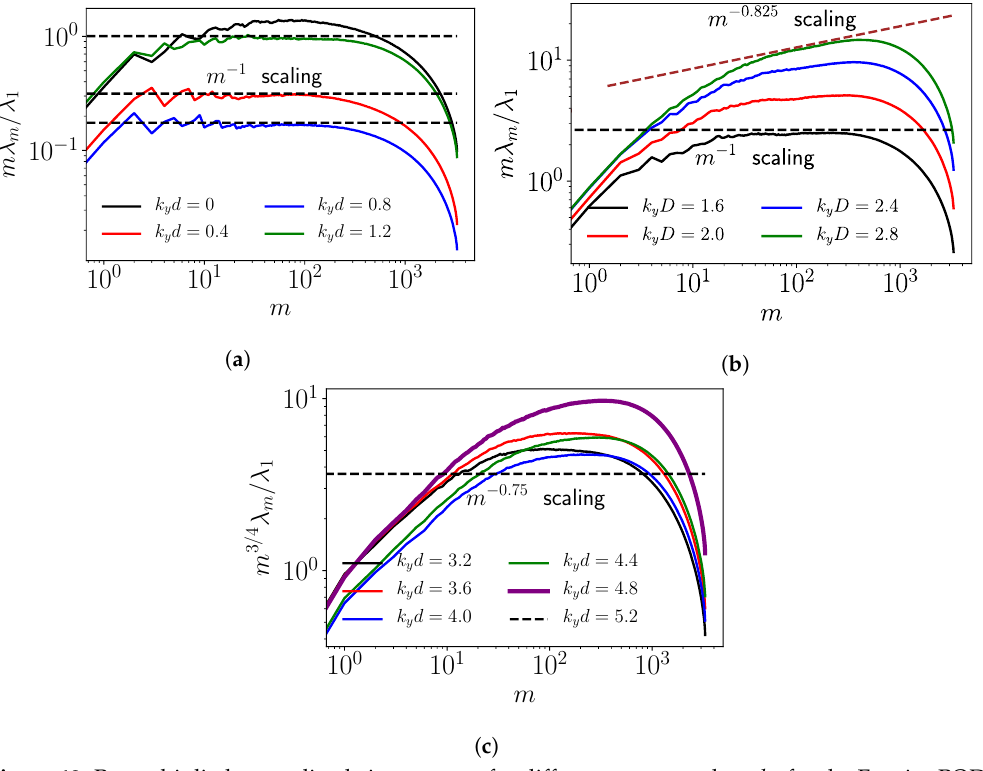
Figure 12. Premultiplied normalized eigenspectra for different wavenumbers k y for the Fourier-POD modes. ( a ) m λ m / λ 1 , for k y d = 0,0.4,0.8,1.2. ( b ) m λ m / λ 1 , for k y d = 1.6,2,2.4,2.8 ( c ) m 3/4 λ m / λ 1 , for k y d =